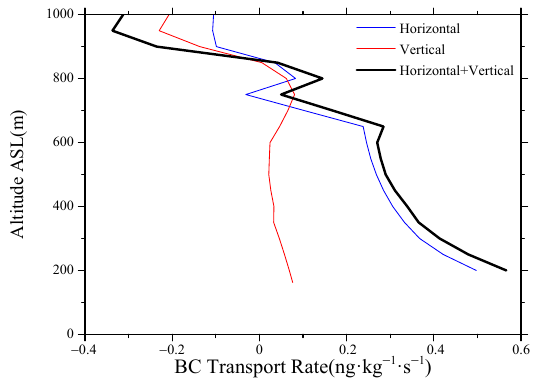
Figure 14. Simulation results of the BC advection transport rate at grid point (97, 76) at 13:00.